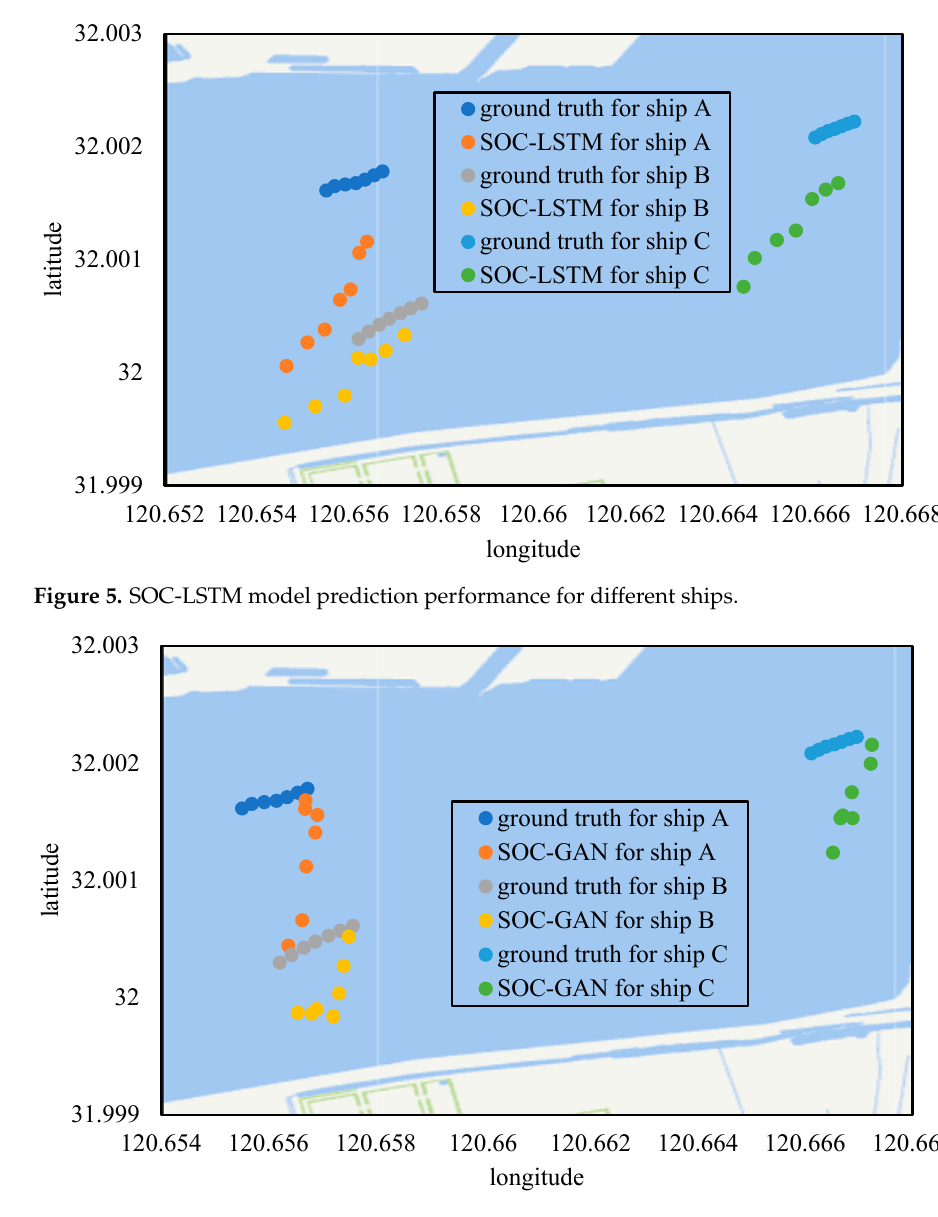
Table 7. Statistical indicator distributions for multiple ship trajectory prediction.